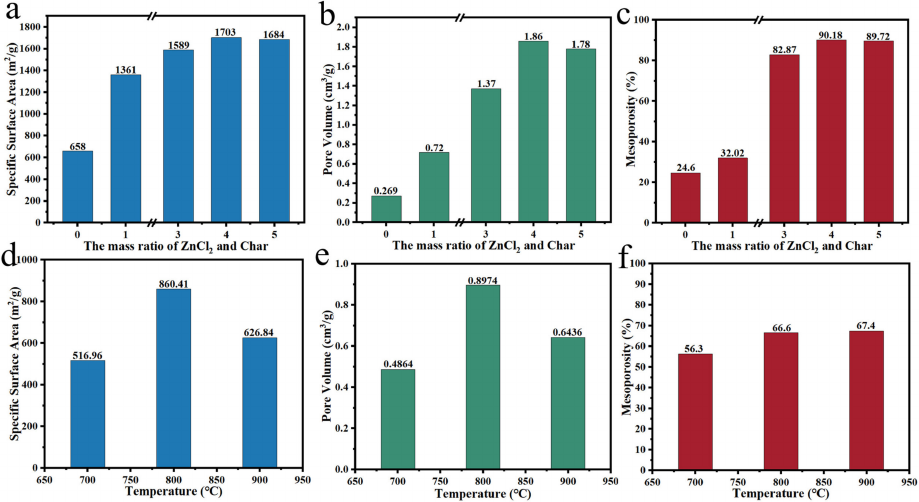
Figure 13. ( a – c ) Impact of the mass ratio of ZnCl 2 and char on ZnCl 2 activation effect [120]; ( d – f ) Impact of the activation temperature on ZnCl 2 effect [121].